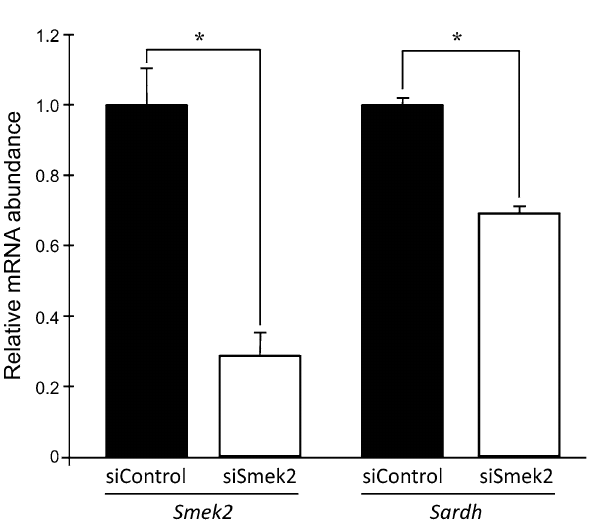
Figure 2. Gene expression in MCA-RH 7777 rat hepatoma cells with Smek2 siRNA. Values are shown as means ± SEM. n = 4/group, *Significantly different at P < 0.01 by Student’s t